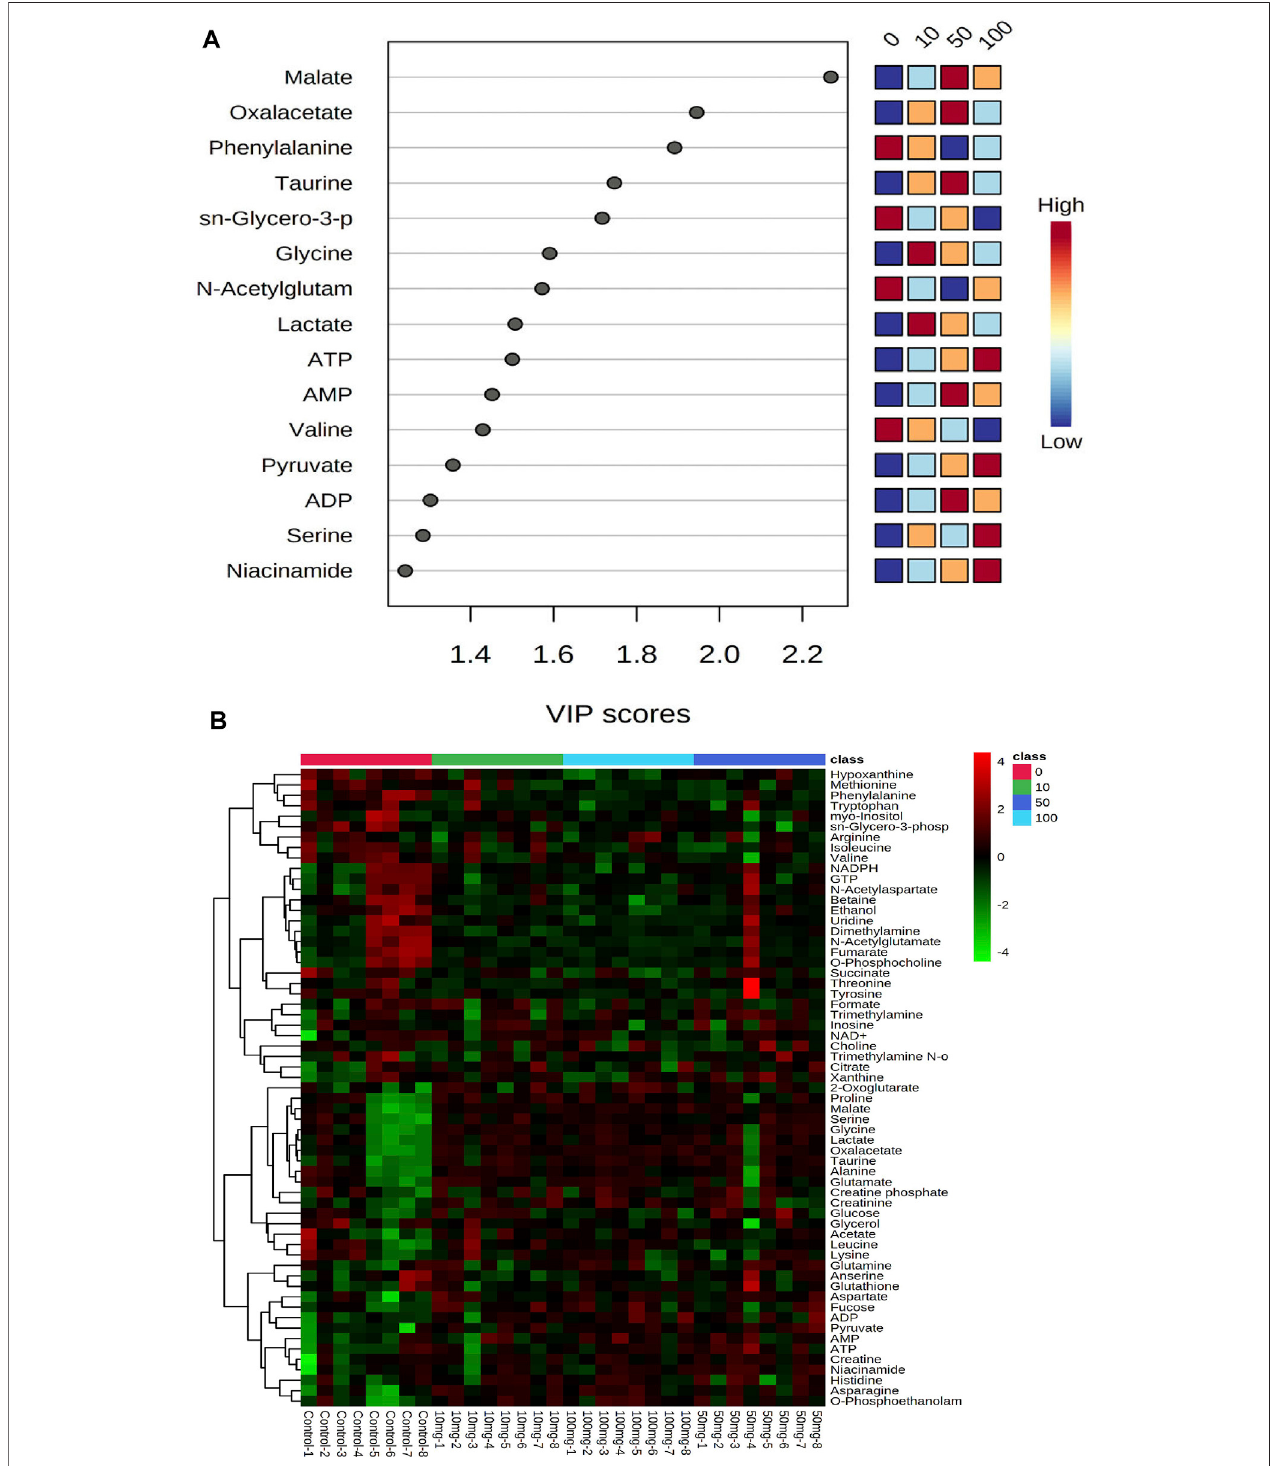
FIGURE 2 | Interactive heatmap analysis with metabolites or small molecules dataset visualization in Zebra fi sh after SWCNT exposures. The rows and columns display metabolites and the samples, respectively. The green and red colors indicate down- and upregulated metabolites, respectively, in fi sh fl uid samples. The brightness of each color corresponds to the alteration magnitude compared with the average value. The classes of 0, 10, 50, and 100 indicate control, 0 mg/L, 10 mg/ml, 50 mg/ml, and 100 mg/ml, respectively.